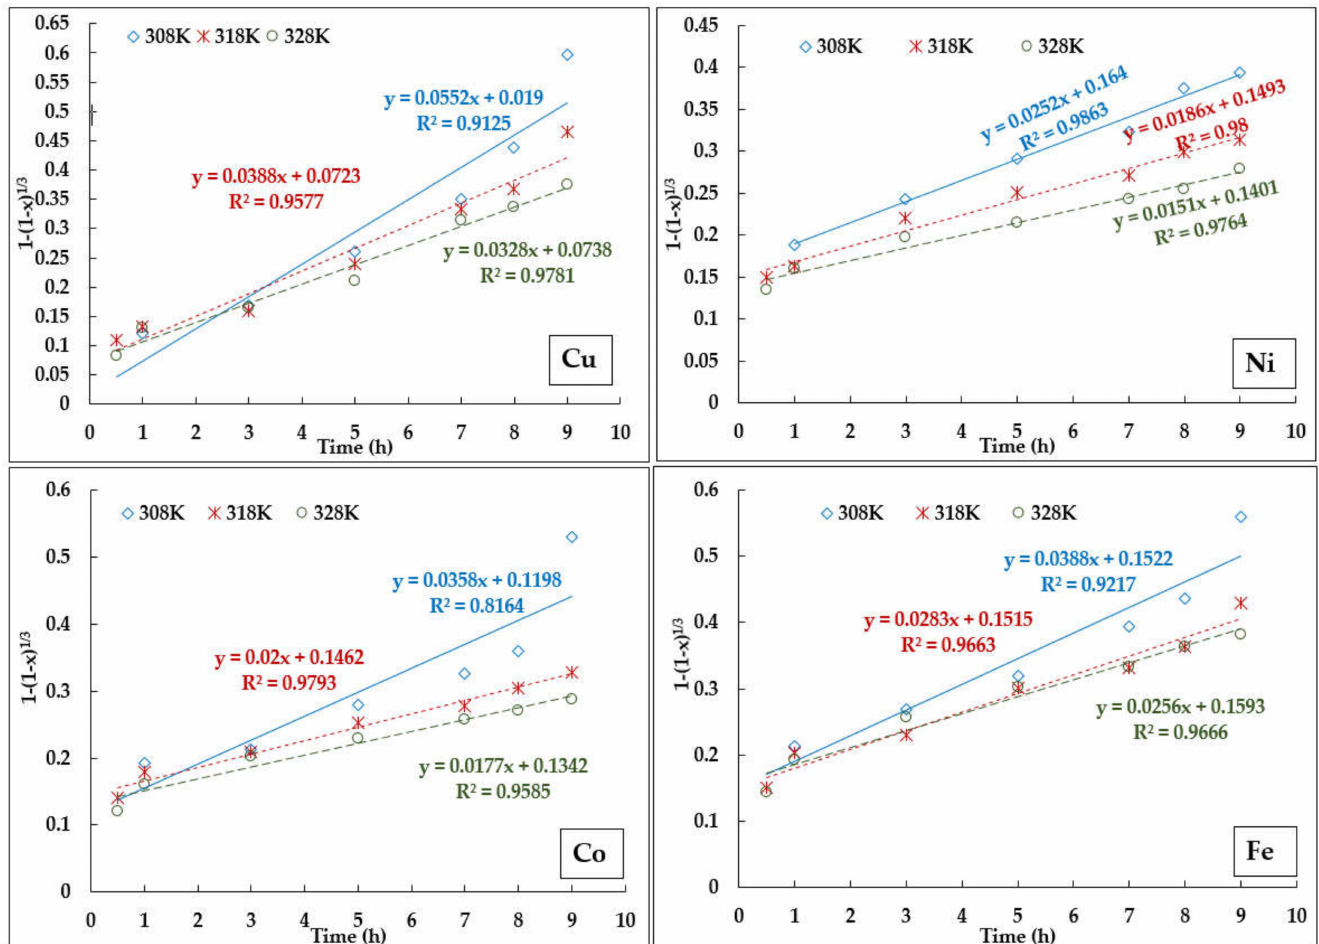
Figure 12. Chemical control model for leaching of Cu, Ni, Co, and Fe from converter slag using 2 N citric acid in temperature range (308–328